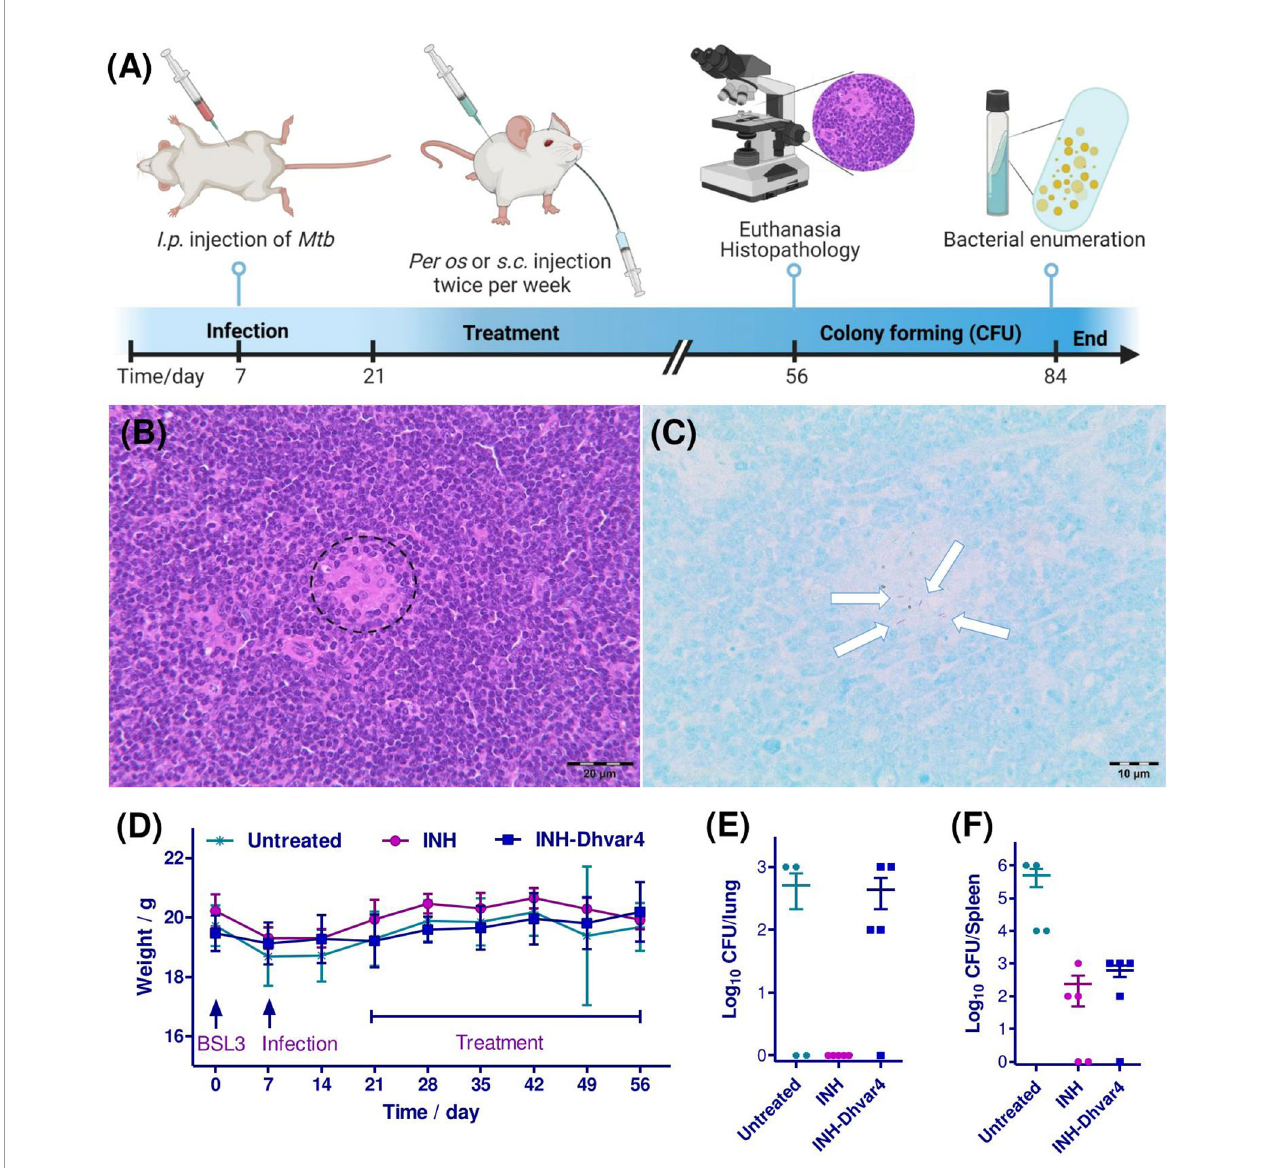
FIGURE 10 | Timeline and results of the in vivo experiments. Mice were infected with M. tuberculosis H37Rv on day 7. After 2 weeks, mice were treated with INH (20 mg/kg bw per os ) and INH-Dhvar4 conjugate (30 mg/kg s.c. ) twice a week for 5 weeks (A) . Histopathological examination of the spleen of untreated control animals showed multifocal, small aggregates of macrophages in the white pulp [ (B) , dashed circle], whereas Ziehl-Neelsen staining prepared from consecutive sections revealed the presence of rod-shaped, acid-fast bacteria within these lesions (C) , arrows], which clearly indicates Mycobacterium tuberculosis infection in the spleen. (D) The weight gain of the mice during the whole experiment. Each treatment group contained fi ve animals, except for the control group, where the experiment ended up with four animals. One week after the 10th treatment, mice were euthanized, and the number of bacteria was enumerated from the tissue homogenates [ (E) , lung; (F) ,